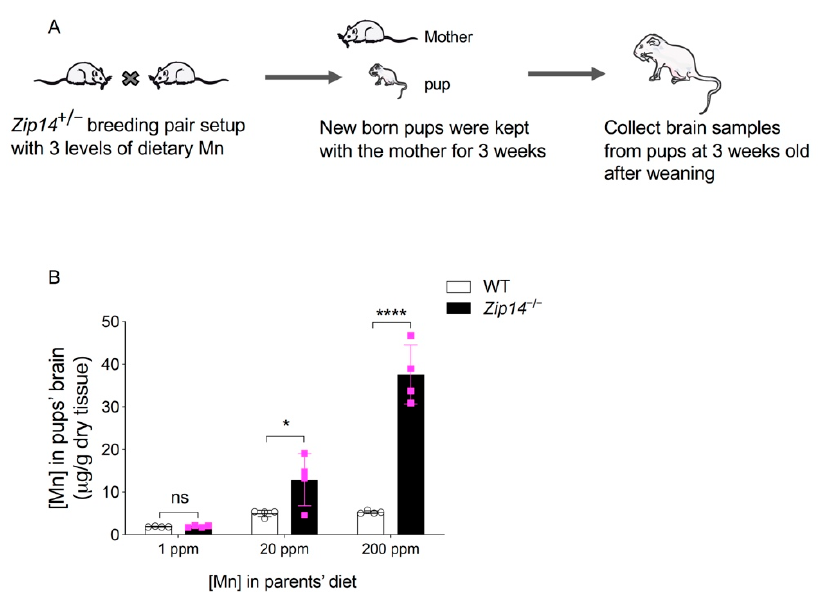
Figure 7. Restricting manganese intake prevents the onset of brain manganese loading in Zip14 − / − mice. ( A ) Schematic illustrating the experimental procedures. Heterozygous Zip14 +/ − mating mice were fed with diets containing low to normal levels of Mn (1 ppm, 20 ppm and 200 ppm). Maternal mice were kept on the same diet during the mating and lactation period. Pups were sacrificed and brain tissues were collected at 3 weeks old after weaning. ( B ) Brain manganese was determined by ICP-MS analysis ( n = 4/group, 2 males and 2 females). Data were expressed as mean ± S.D. and statistical analysis was performed using two-way ANOVA, followed by the Bonferroni post-hoc test to compare results of WT and Zip14 − / − mice. * p < 0.05; **** p < 0.0001; “ns” indicates not significant.